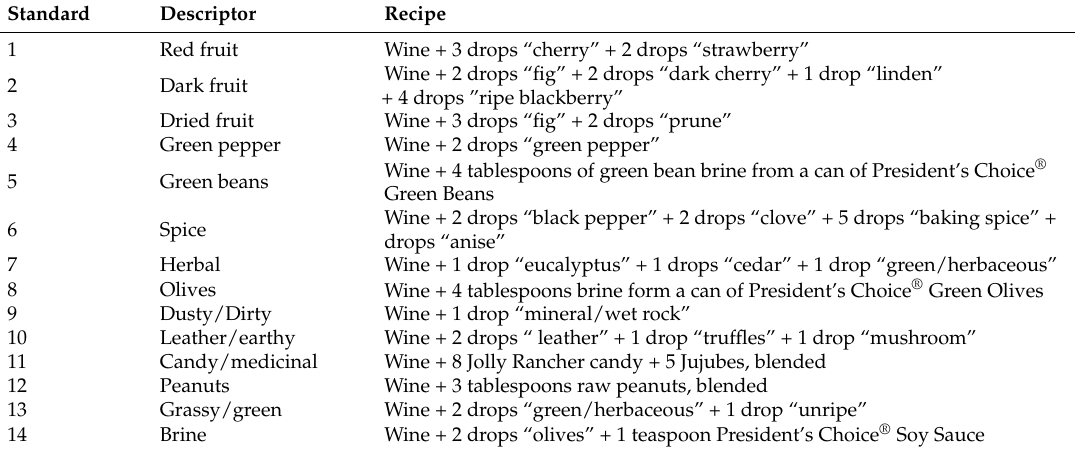
Table 4. Recipes for aroma standards used for panel training. Recipes were prepared using 500 mL of Merlot base wine and aroma standards from the Wine Awakenings ® Kit or other commercial products, as